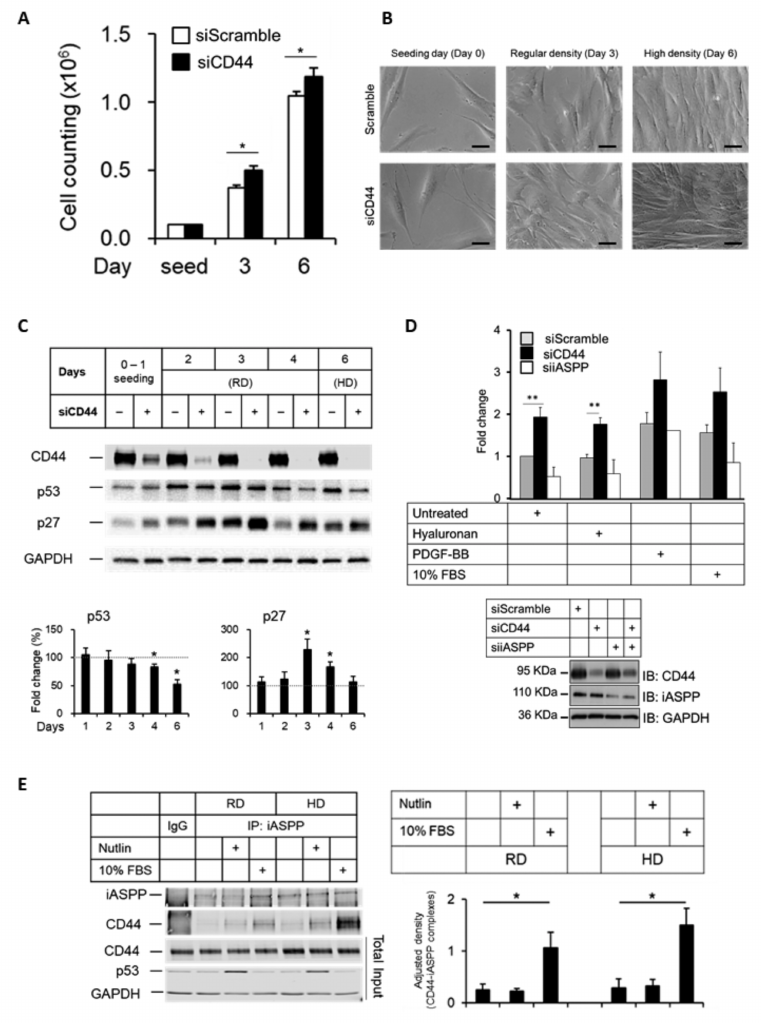
Figure 6. Knock-down of CD44 in AG1523 fibroblast leads to loss of contact inhibition. ( A , B ) AG1523 fibroblasts, transfected with CD44 siRNA or scramble siRNA, were seeded in 6-well plates and grown to a density of 10 5 cells per well (regular density; RD) or >10 6 cells per well (high density; HD), counted, and observed under microscopy. Scale bars, 20 µ m. ( C ) Cell lysates from RD and HD cell cultures were subjected to immunoblotting using indicated antibodies. ( D ) AG1523 cells, treated with CD44 siRNA, iASPP siRNA, or scramble siRNA, were stimulated, or not, with hyaluro- nan, PDGF-BB, and 10% FBS, and then subjected to a 3 H-thymidine incorporation assay. Knock-down efficiencies are shown in immunoblots. ( E ) Cell lysates from RD and HD cell cultures, incubated in Nutlin or 10% FBS, were subjected to immunoprecipitation using an iASPP antibody, followed by immunoblotting using indicated antibodies. The data are plotted in bar graphs representing the mean ± SD of at least three independent experiments (* p < 0.05 and ** p < 0.01, Student’s t -test). The uncropped blots are shown in File